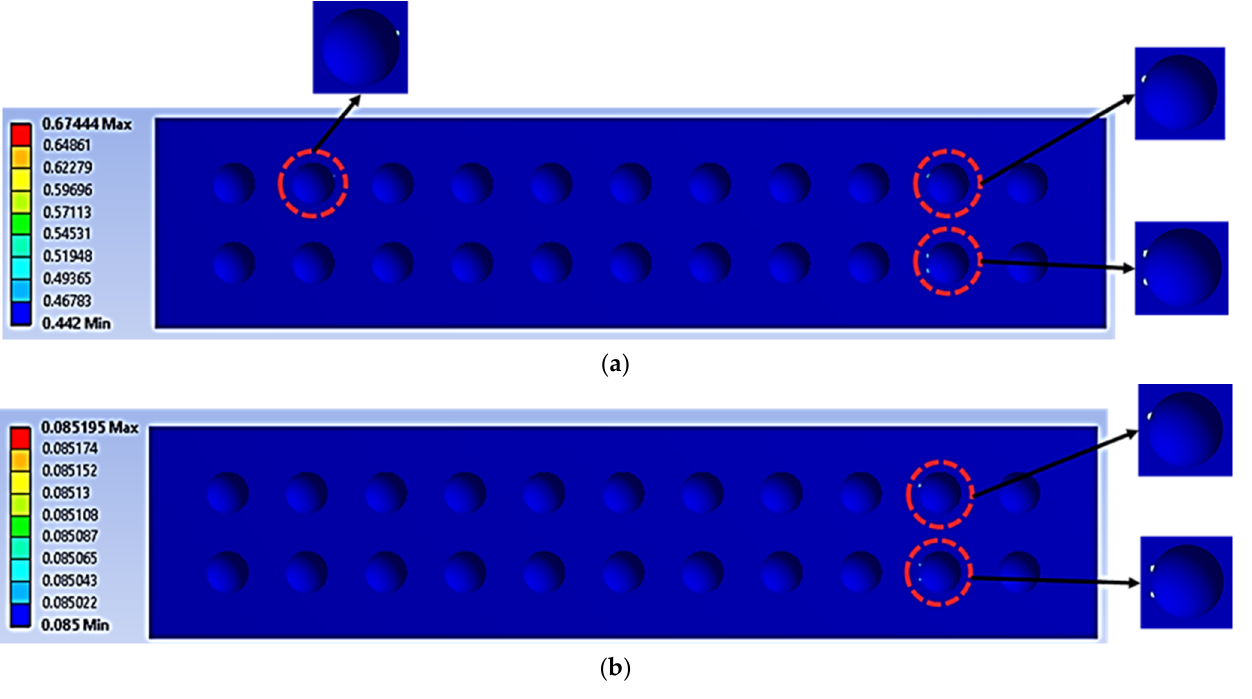
Figure 13. The maximum damage points region (indicated with red circles—see the zoom-in) on the core panel under cyclic loading conditions of: ( a ) 70%, ( b ) 50% (no unit for the damage value as the maximum damage value is equal to 1). Table 5. FEA results for all the alternative core designs at 70% of cyclic loading conditions.